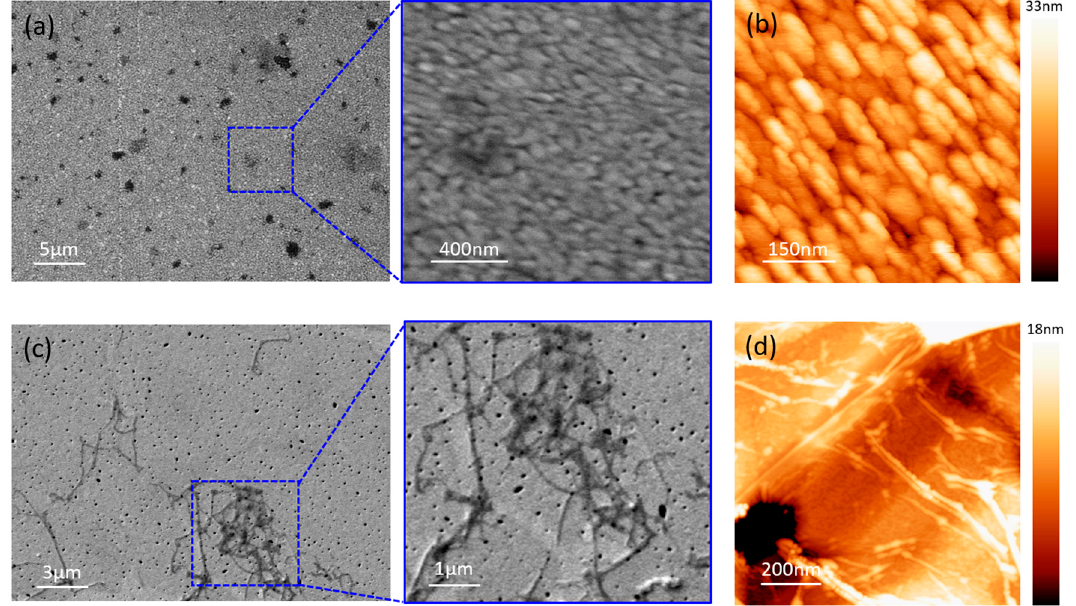
Figure 5. Morphological and topographic characterization of samples after biological interaction. Au sample grown on mica without graphene ( a ) SEM image and ( b ) STM image (550 × 550 nm 2 , I = 0.05 nA, V BIAS = 1 V) and Graphene/Au sample ( c ) SEM image and ( d ) STM image (950 × 950 nm 2 , I = 0.03 nA, V BIAS = 0.9 V).